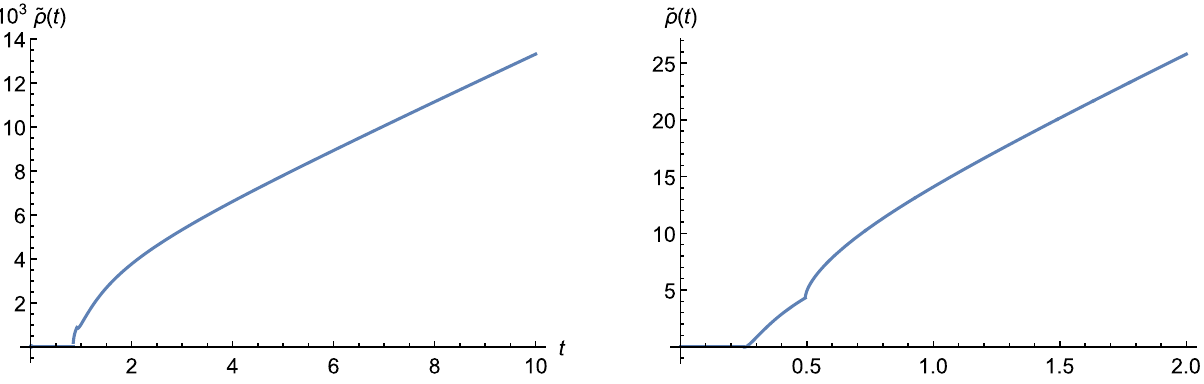
Fig. 7 Spectral function for the transverse two-point correlation function G R ( p 2 ) , with t given in units of μ 2 , for the Region I (left) and Region II (right) with parameter values given in Table 1